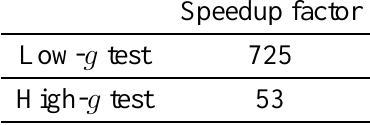
Table 1. Computational gain, given by the ratio between the FE CPU time and the ROM CPU